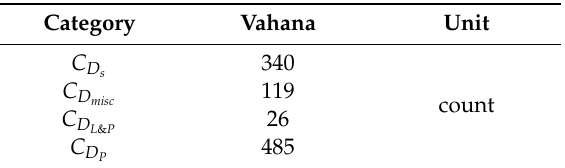
Table 10. Vahana parasite drag.